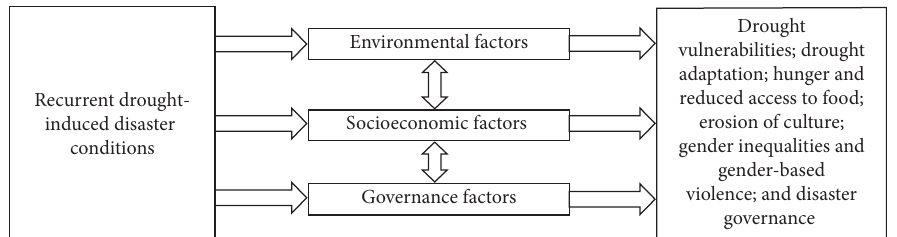
Figure 2: Reciprocal translation of studies into